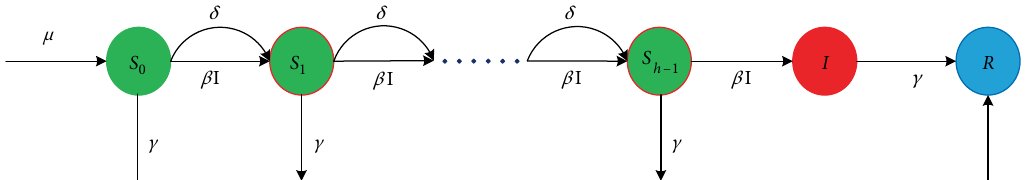
Figure 1: The state transition process of individuals involved in rumor